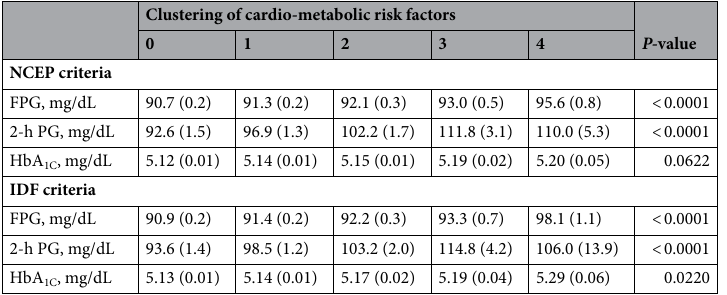
Table 2. Mean FPG, 2-h PG and HbA 1C levels according to clustering of cardio-metabolic risk factors. Adjusted for sex, age, race/ethnicity, and survey